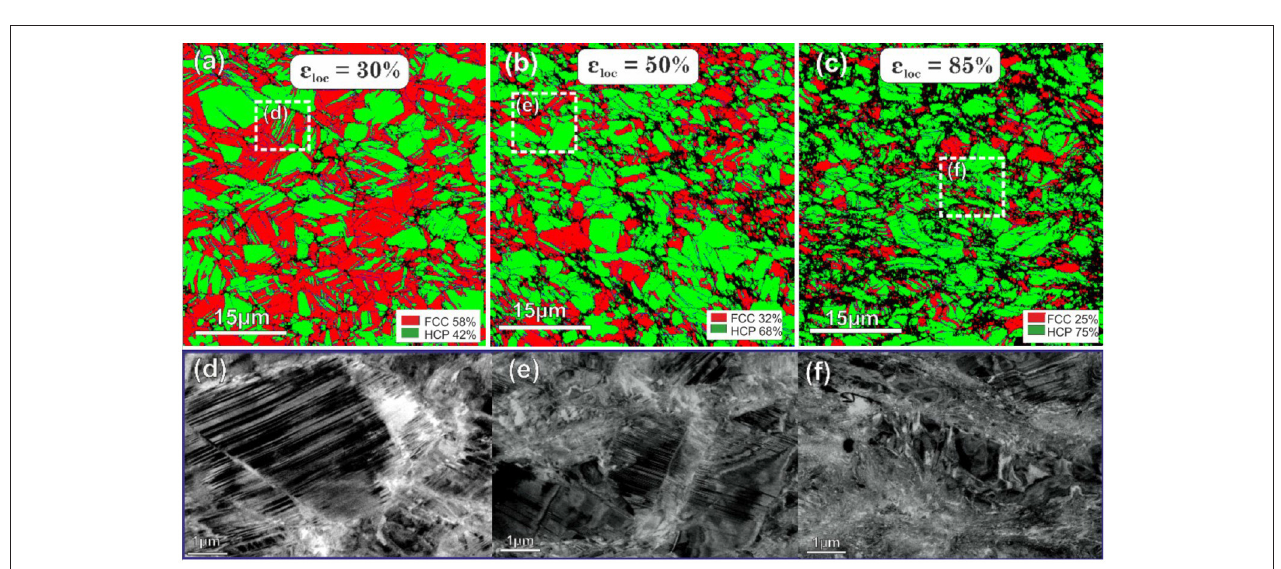
FIGURE 7 | EBSD phase maps (a–c) and ECC images (d–f) showing the deformation microstructures in the fine-grained DP-HEA sample with an average grain size of ∼ 2.8 µ m and a starting HCP phase fraction of ∼ 25% at varying local strain ( ε loc ) levels (30, 50 and 85%) after tensile testing at a constant strain rate of 5 × 10 − 3 s − 1